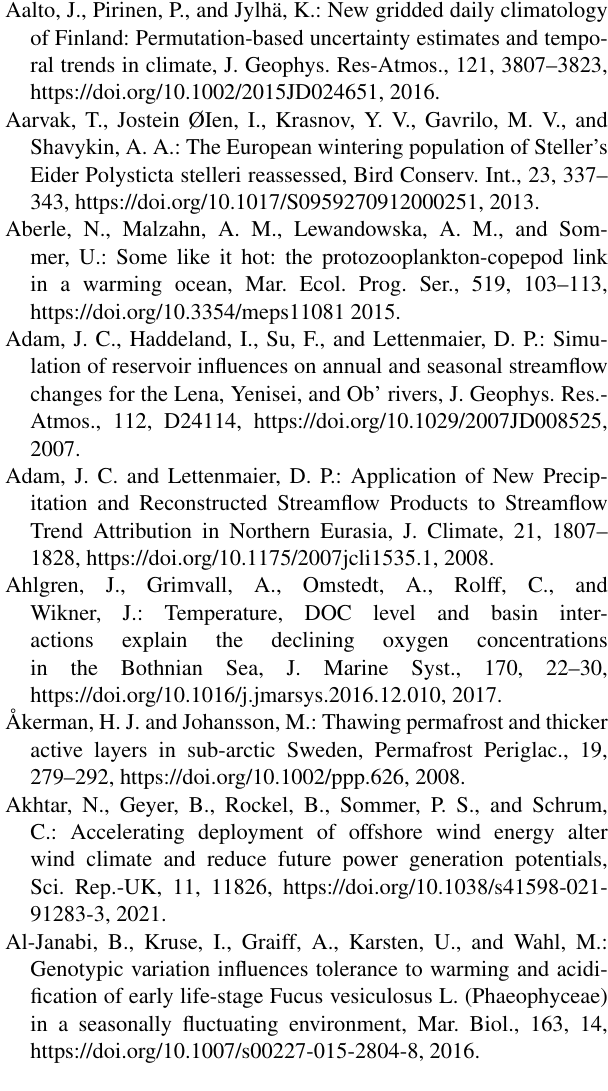
Fig. 9, https://www.smhi.se (SMHI, 2022) for Figs. 10, 23,